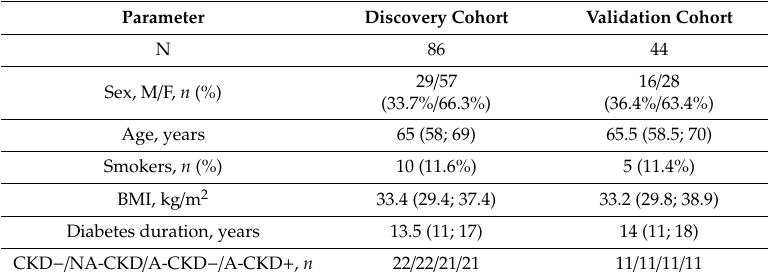
Table A1. Characteristics of T2D patients in the discovery and validation cohorts